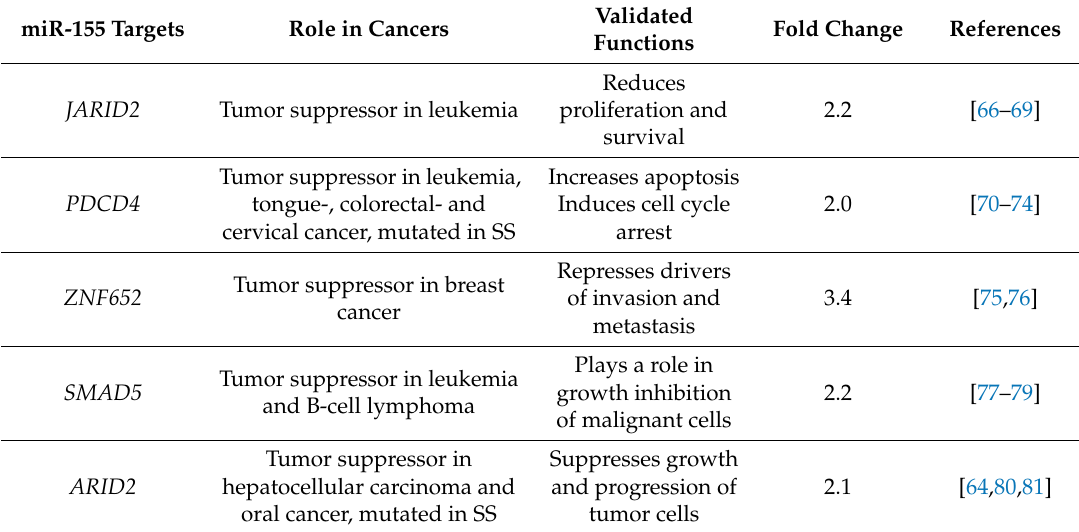
Table 1. Putative miR-155 targets in